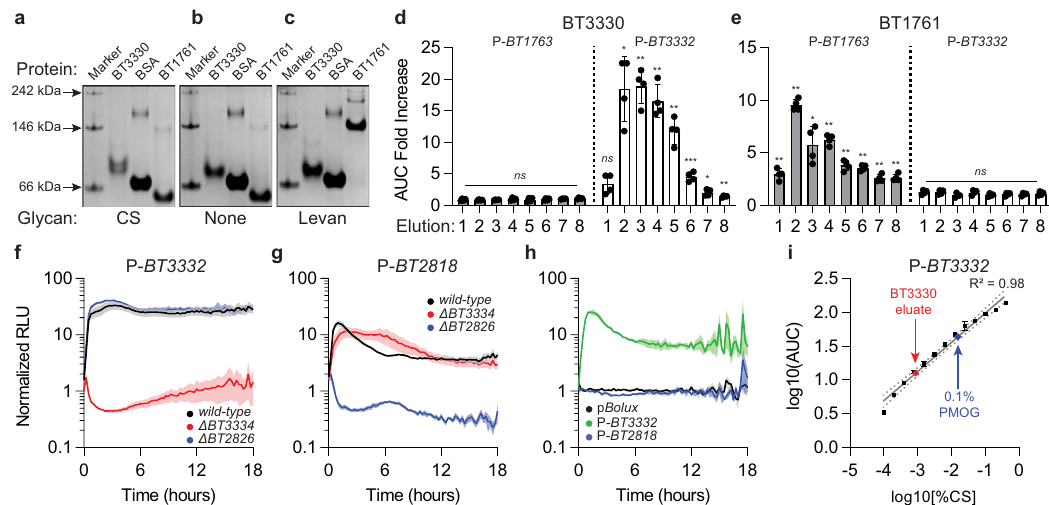
Fig. 7 | PUL reporters facilitate SGBP-mediatedtargetglycanisolation. Puri fi ed BT3330, BSA, or BT1761 was analyzed by af fi nity-PAGE in the presence of ( a ) 0.1% CS, ( b ) no glycan or ( c ) 0.1% levan. Images are representative of 3 independent experiments. The fold difference in AUC from wild-type Bt strains harboring